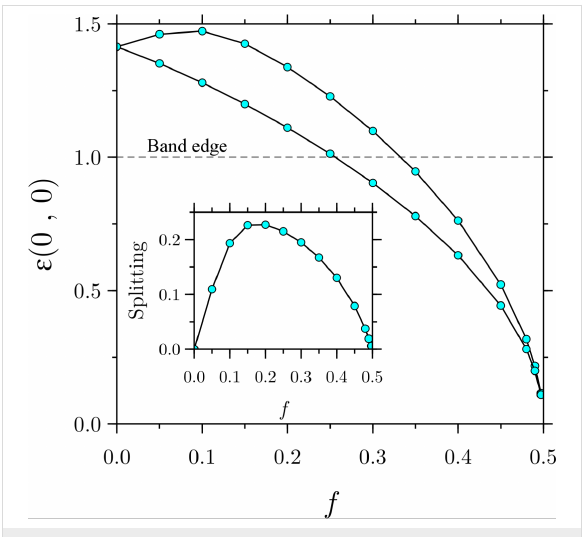
Figure 5: Splitting of the Landau levels at and b = 0.5 as a function of the electric field. It is important to note that the Landau levels move below the band edge due to the bending by the electric field (see main text for details).